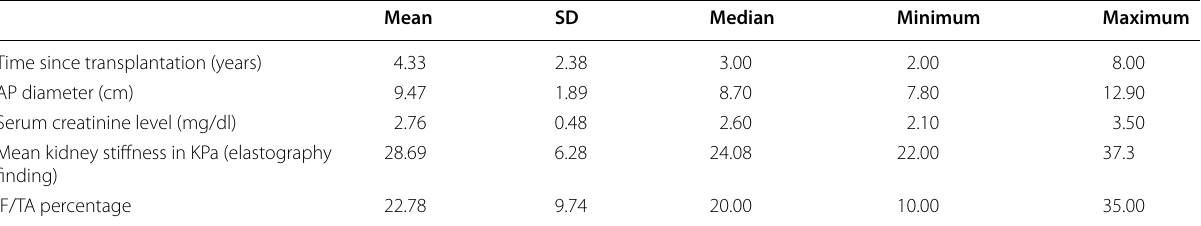
Table 1 Clinical, laboratory and ultrasound characteristics of 36 patients with histological samples and stiffness